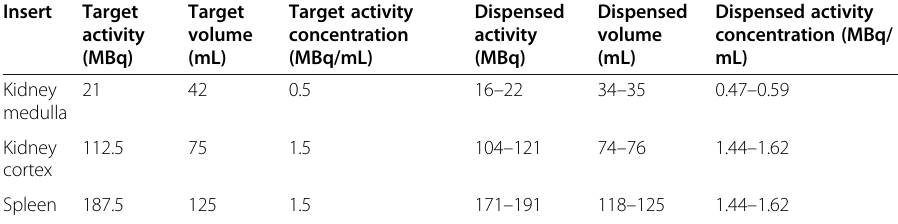
Table 3 Target and dispensed activities and filling volumes for the two-organ phantom inserts with the range of reported values from the comparison exercise